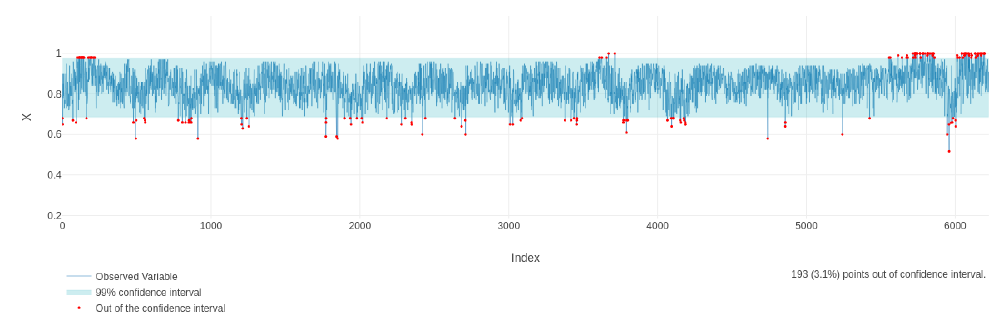
Figure 6. SPC control chart, considering a 99% of tolerance based on the AU model fitted to the daily maximum relative humidity of Copiapó city, Chile, from 1 February 2015 to 4 October 2022. It is observed that 193 days (3.1%) presented anomaly values (out-of-control signals). The obtained control limits were: LCL = 68.56% and UCL =